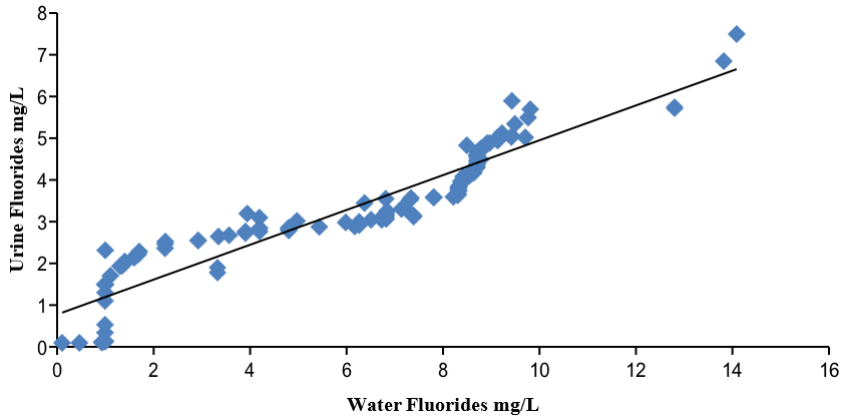
Figure 1: Scatter chart between Water and Urine Fluoride of sample Group Pearson Correlation Coefficient r =